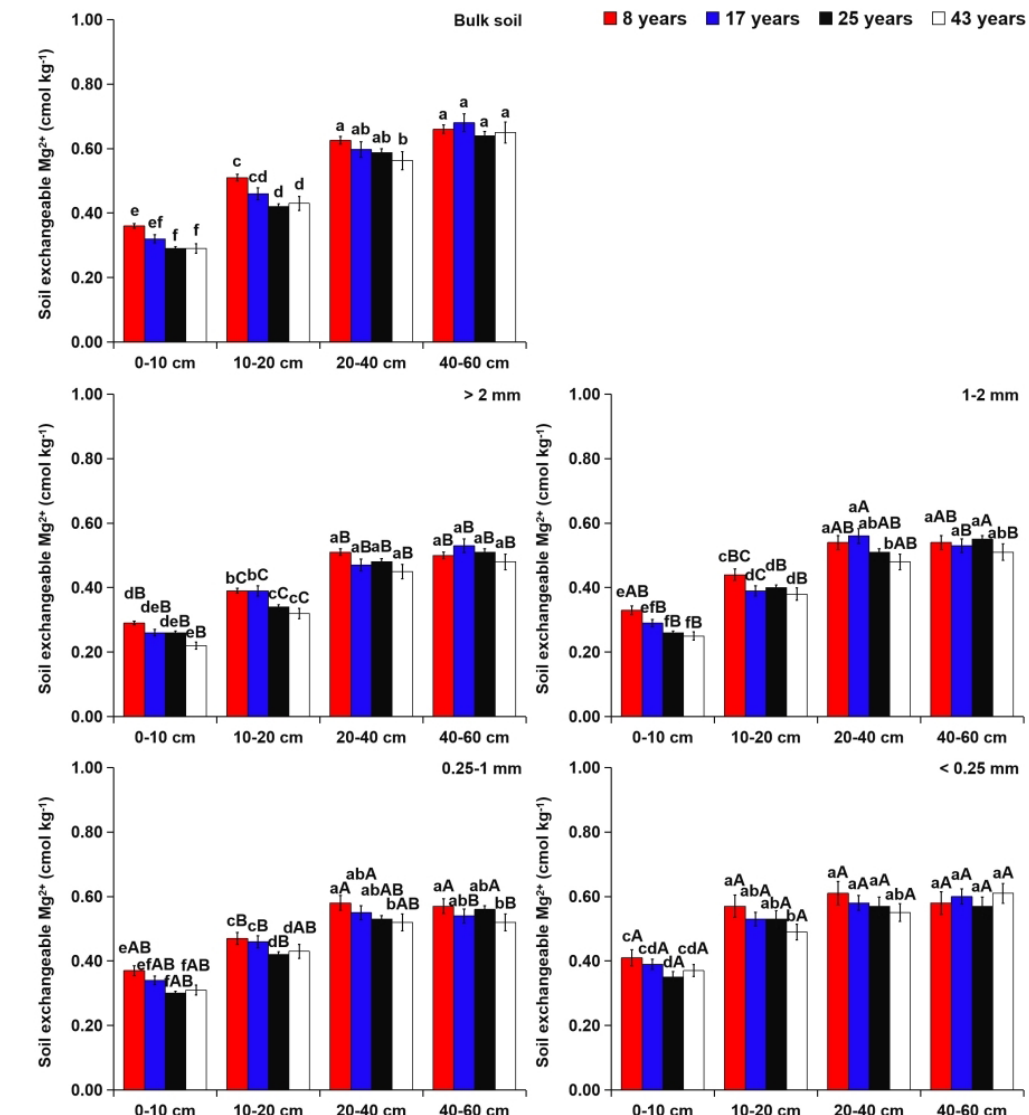
Figure 6. Effects of soil depth and tea plantation age on the exchangeable Mg 2 + content in bulk soil and different-sized aggregates. Data represent the mean of five replicates, and error bars represent the standard deviations. Means with the same lowercase letter are not sig- nificantly different ( p > 0 . 05) among different soil depths and tea plantation ages. Means with the same capital letter are not significantly different ( p > 0 . 05) among different-sized